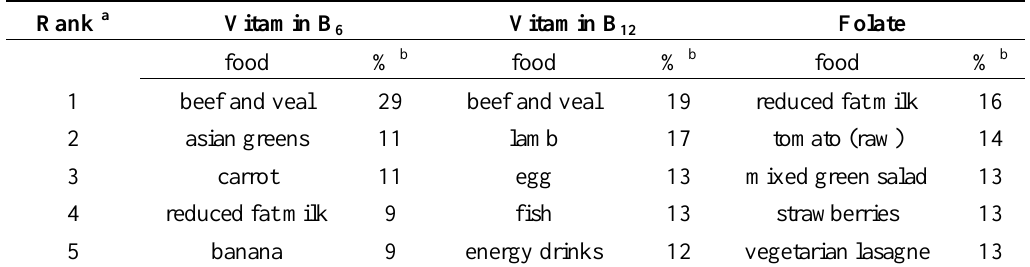
, vitamin B and 6 12